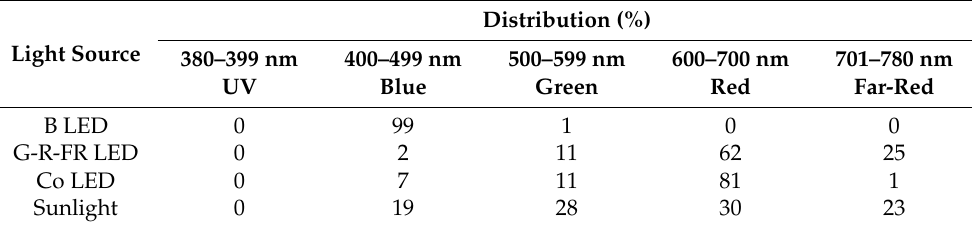
Table 3. The fraction of spectrum distribution of the LED light sources. Indicative solar light level recorded at 13:00 (solar midday) 5 July 2021 above the control treatment plants. Co (control), B (blue); G-R-FR (green/red/far-red).